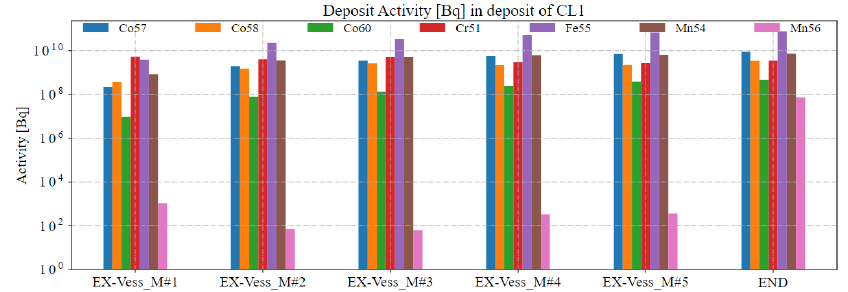
Figure 4. EU-DEMO Divertor cassette PHTS Cold Leg no. 1 deposit